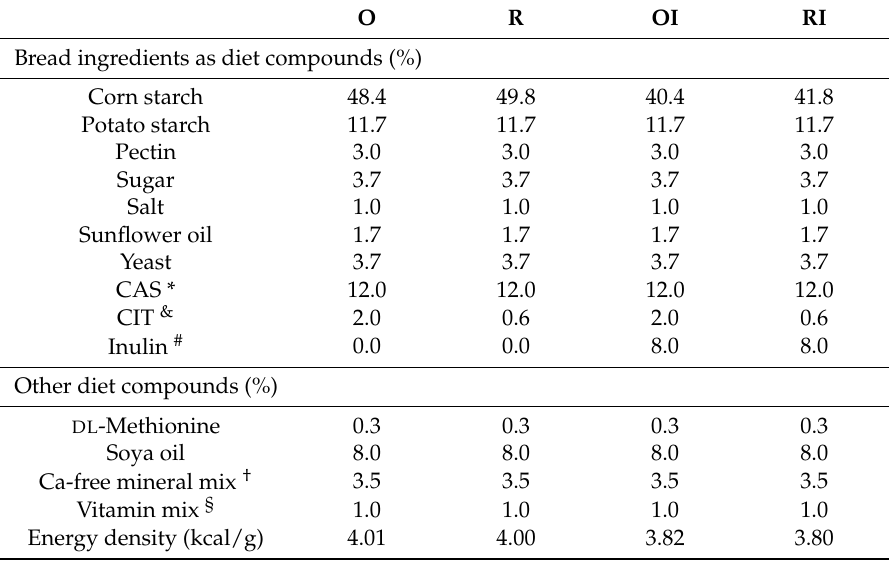
Table 1. Experimental gluten-free diets. O R OI RI Bread ingredients as diet compounds (%) Corn starch 48.4 Potato